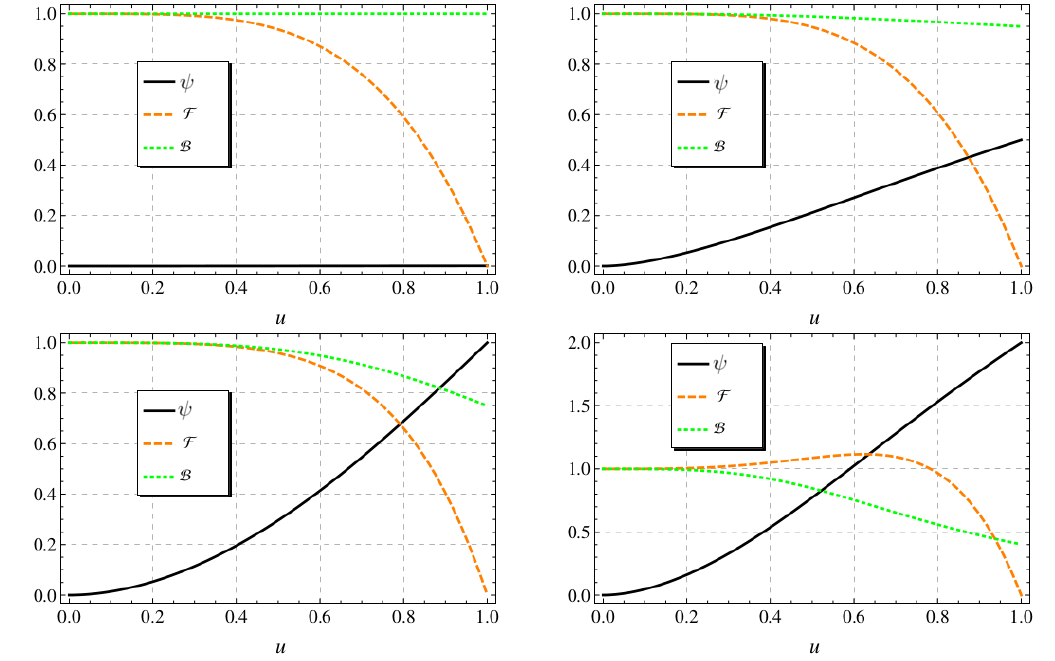
Figure 1 . The solutions for ; (bottom left) and c = 2 (bottom